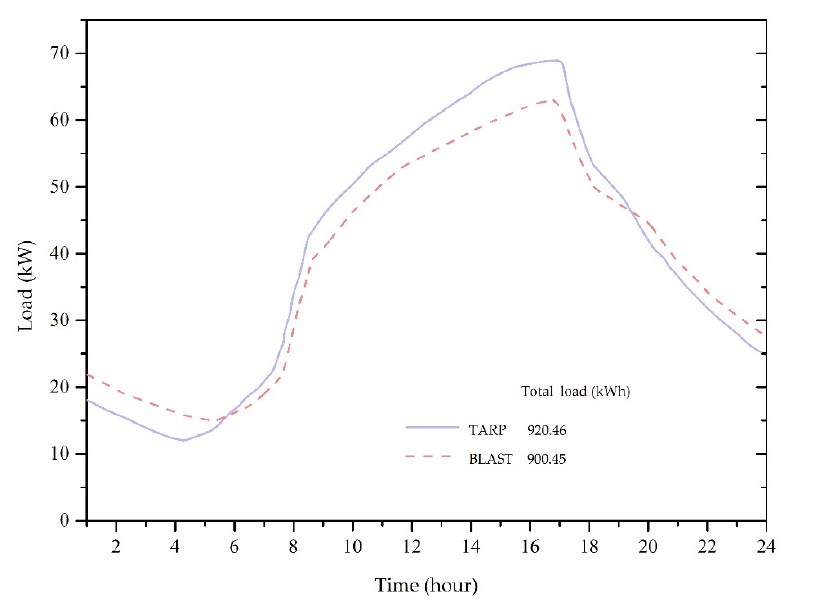
Figure 4. Comparison between the estimations of the BLAST and Thermal Analysis Research Program (TARP) programs for an office space on summer design day.